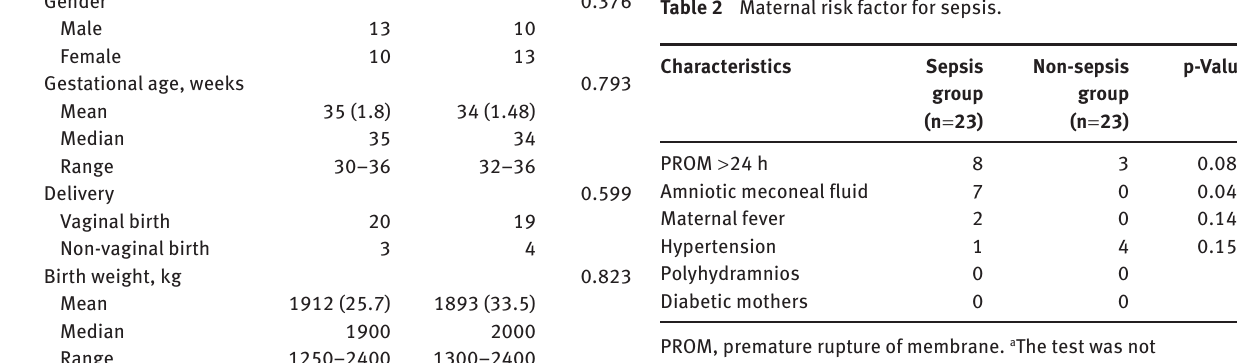
Table 2 Maternal risk factor for